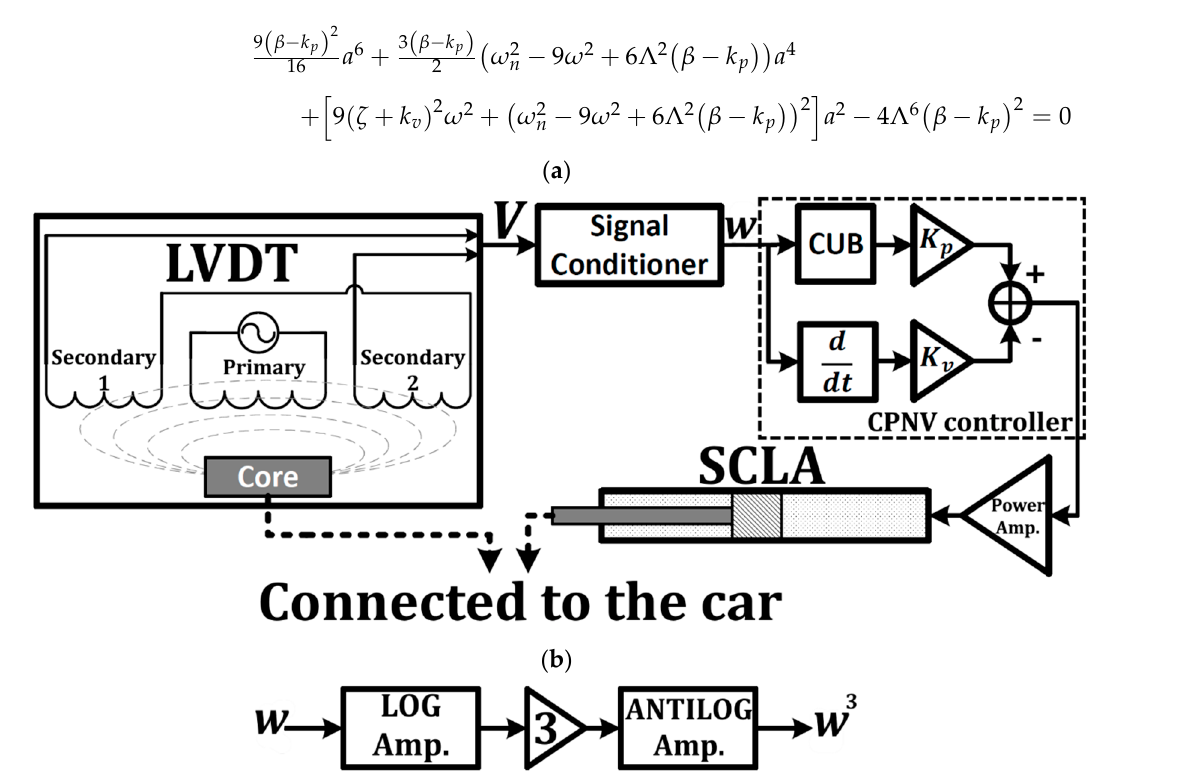
Figure 2. Block diagrams of: ( a ) the control unit and ( b ) the cuber (CUB) unit.